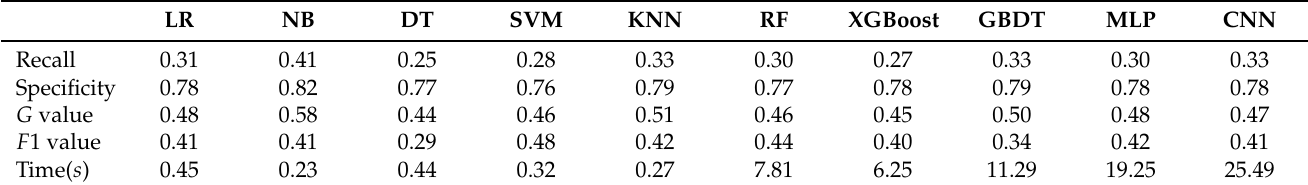
Table 6. Evaluation measures of each machine learning model in the multi-imbalanced MEEI dataset.